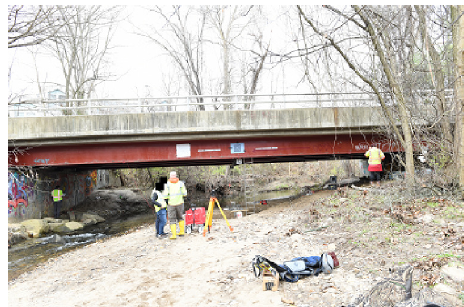
Figure 8. Delaware I-213 bridge.